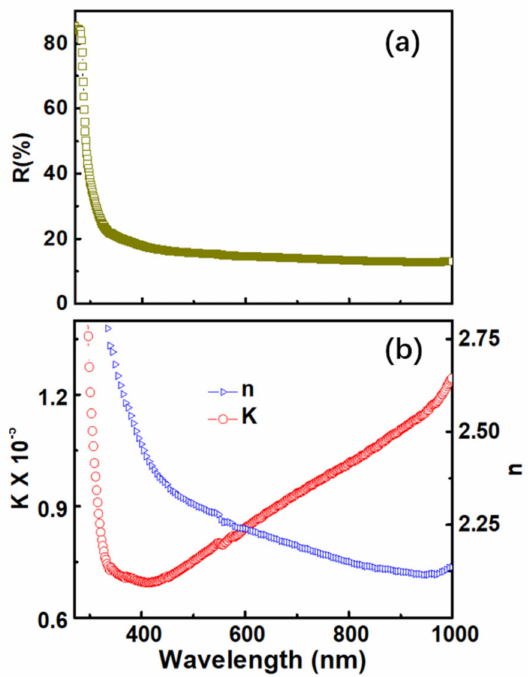
Figure 7. ( a ) The derived reflectance index of the as-grown crystal, and ( b ) graphical variations of the refractive index and extinction coefficient as a function of the incident wavelength for the as-grown CaNb 2 O 6